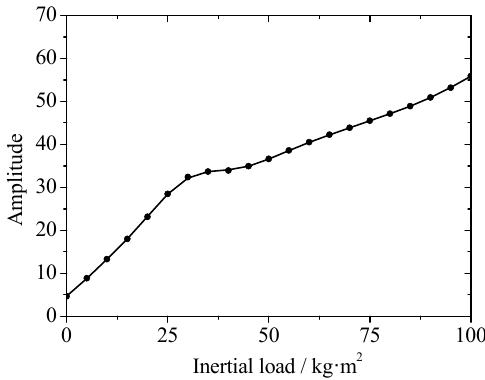
Figure 15. Radial vibration amplitude of planet carrier under different inertial loads.